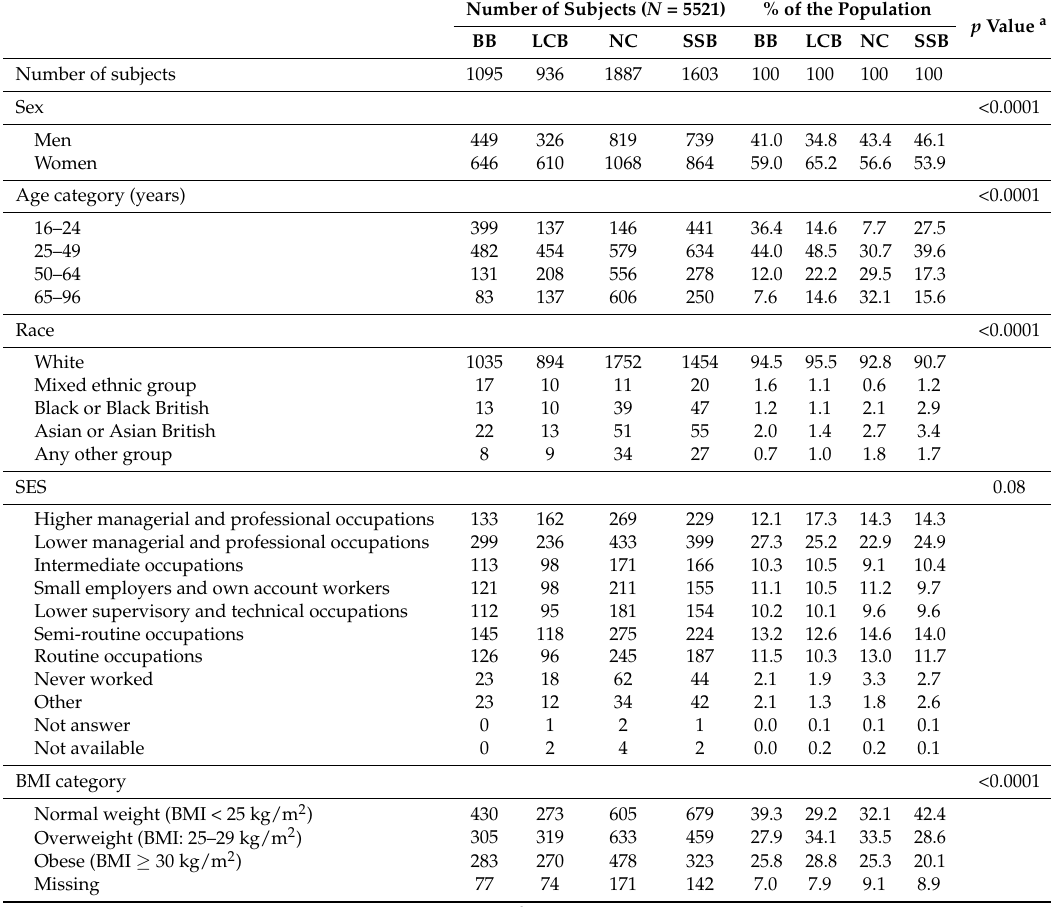
Table 1. Characteristics of the population according to type of beverage